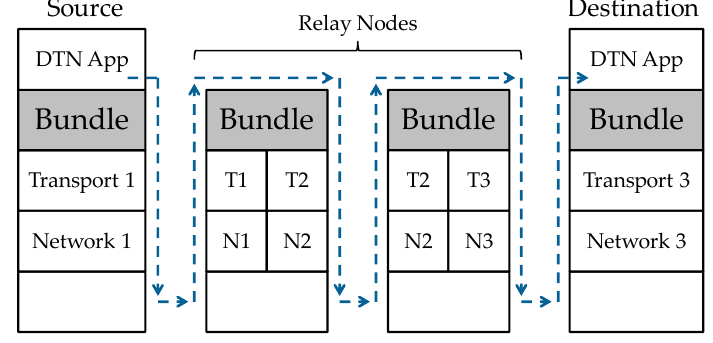
Figure 8. DTN protocol stack. Note: T; Transport, N; Network.